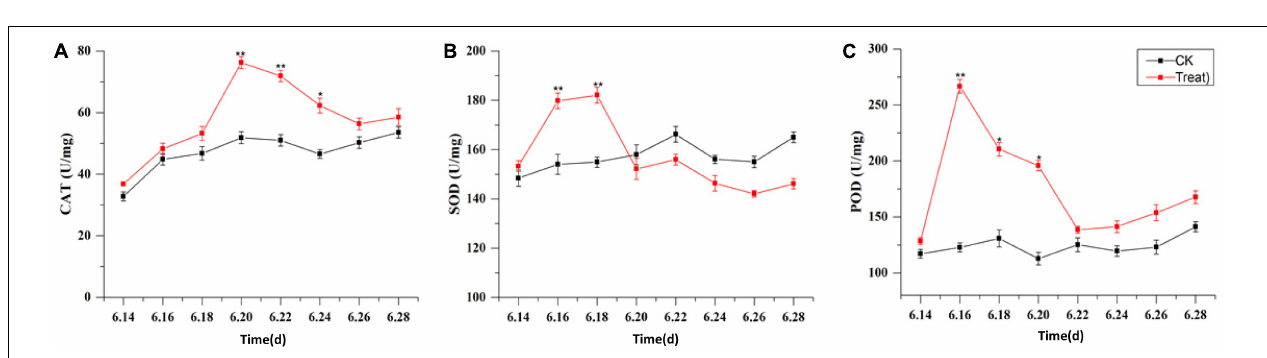
FIGURE 9 | The content of malondialdehyde and osmoregulatory substances under cold stress. Panels (A–D) show the MDA, Pro, SP, and SS content under cold stress. The X axis represents the sampling time. * p < 0.05 and ** p < 0.01, compared with control group. The data are expressed as the mean ± SD ( n = 3).